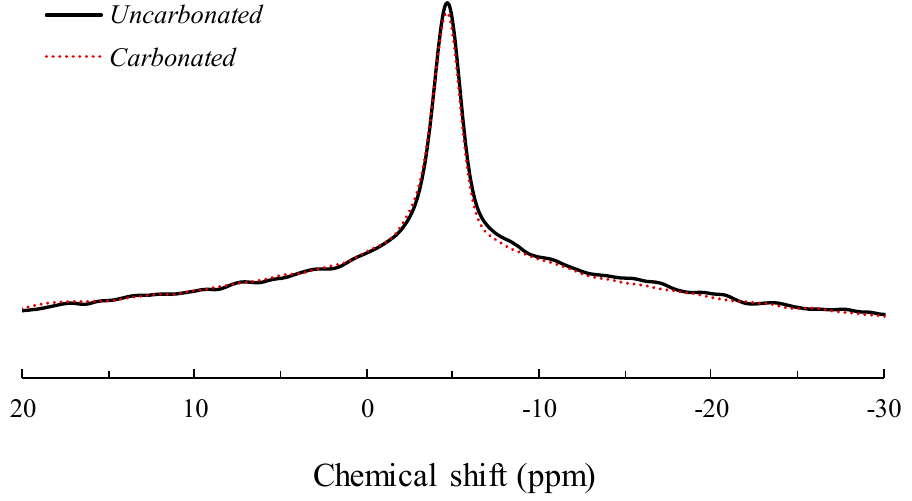
Figure 3. 23 Na MAS NMR spectra of uncarbonated and carbonated alkali-activated fly ash.